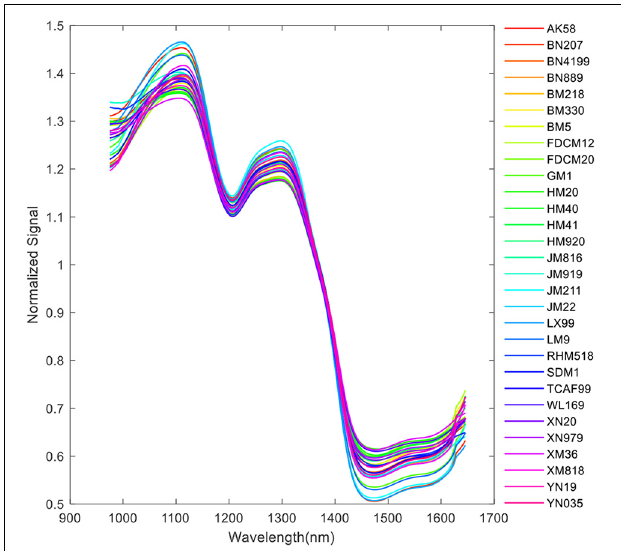
FIGURE 3 | Spectral profiles of the 30 varieties of wheat